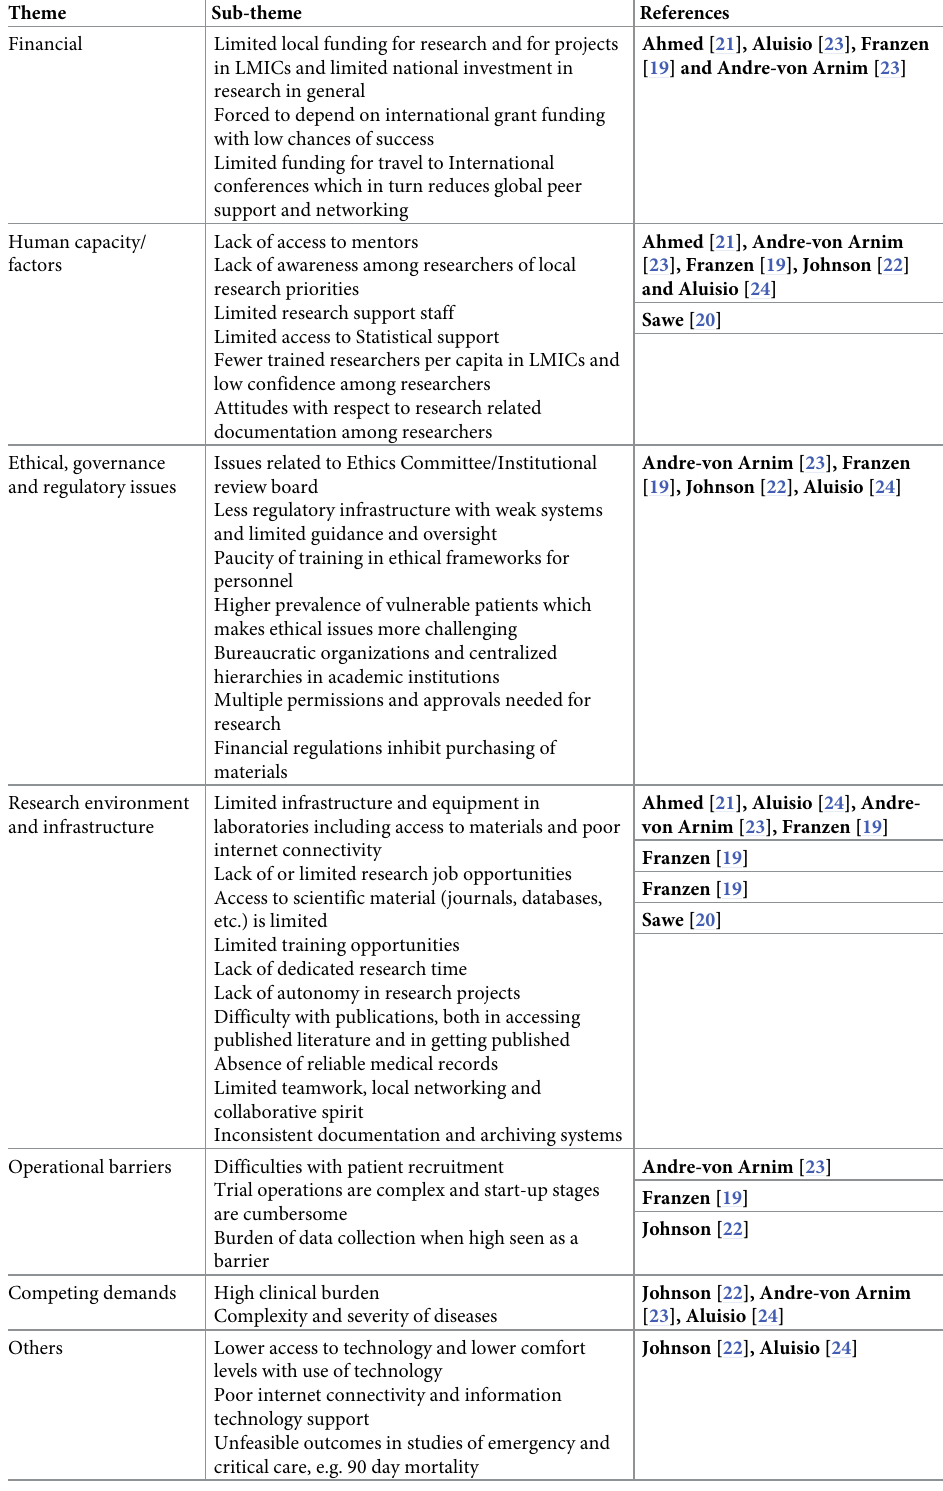
Table 2. Barriers for the conduct of critical care research in